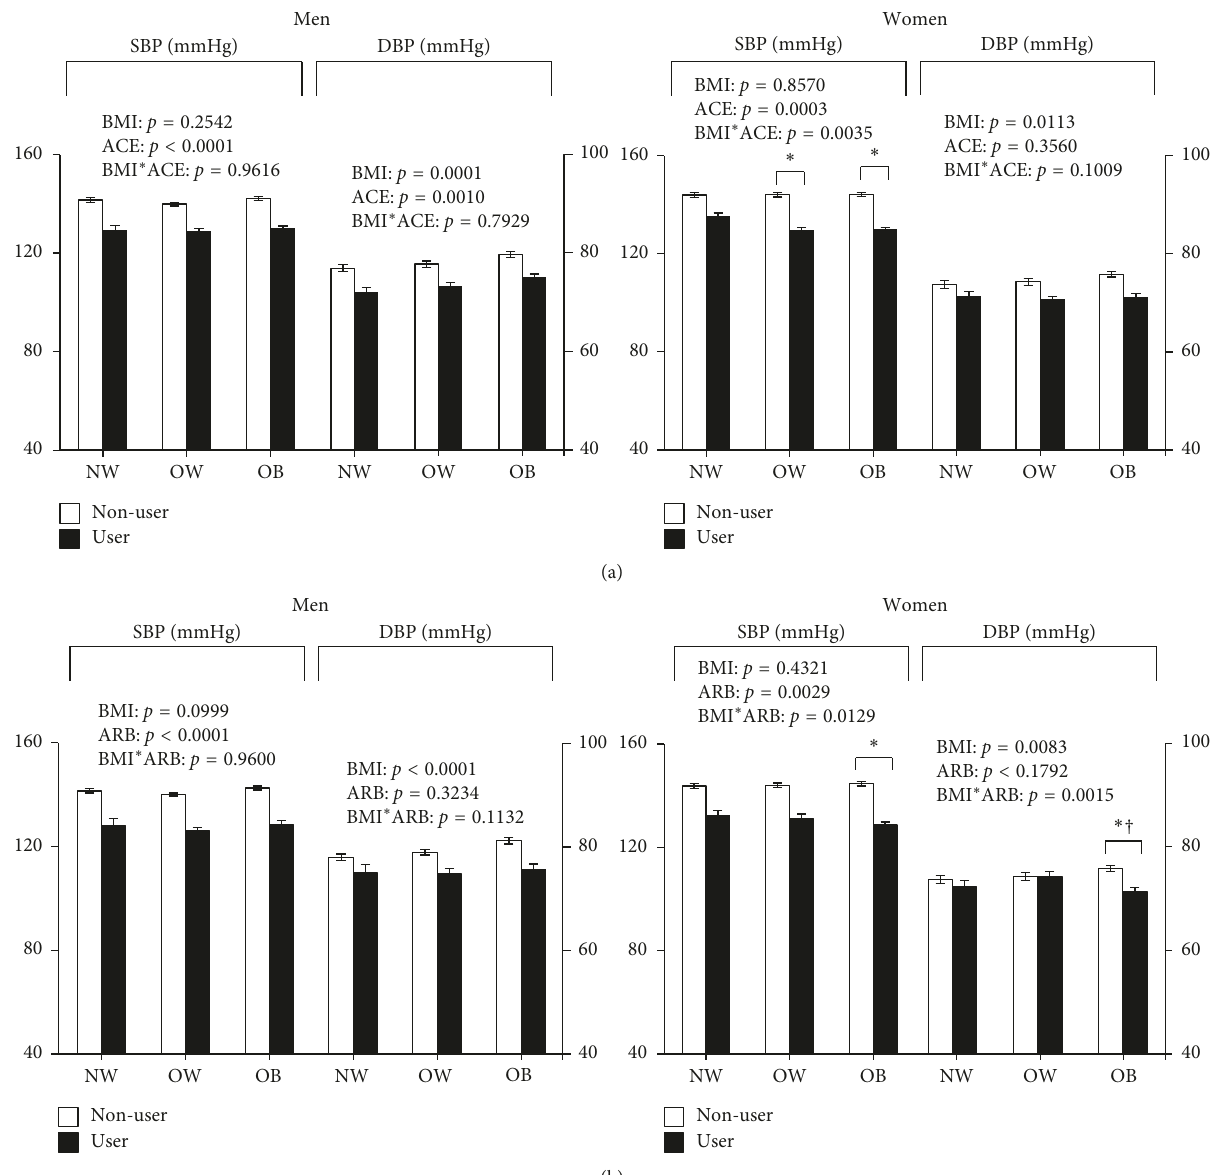
Figure 2: Mean blood pressures (mmHg) among hypertensive adults using (a) ACE Inhibitors and (b) ARBs by BMI category and gender. Sample includes individuals on combination antihypertensive therapy. Means are adjusted for age, ethnicity, health insurance status, smoking status, physical activity, education, and number of antihypertensive medications taken. BMI � body mass index; ACE � ACE inhibitor; ARB � angiotensin receptor blocker; NW � normal weight; OW � overweight; OB � obesity; BP � blood pressure; SBP � systolic blood pressure; DBP � diastolic blood pressure. ∗ Difference between users and nonusers significantly different from normal weight ( P < 0 . 05); † difference between users and nonusers significantly different from overweight ( P < 0 .